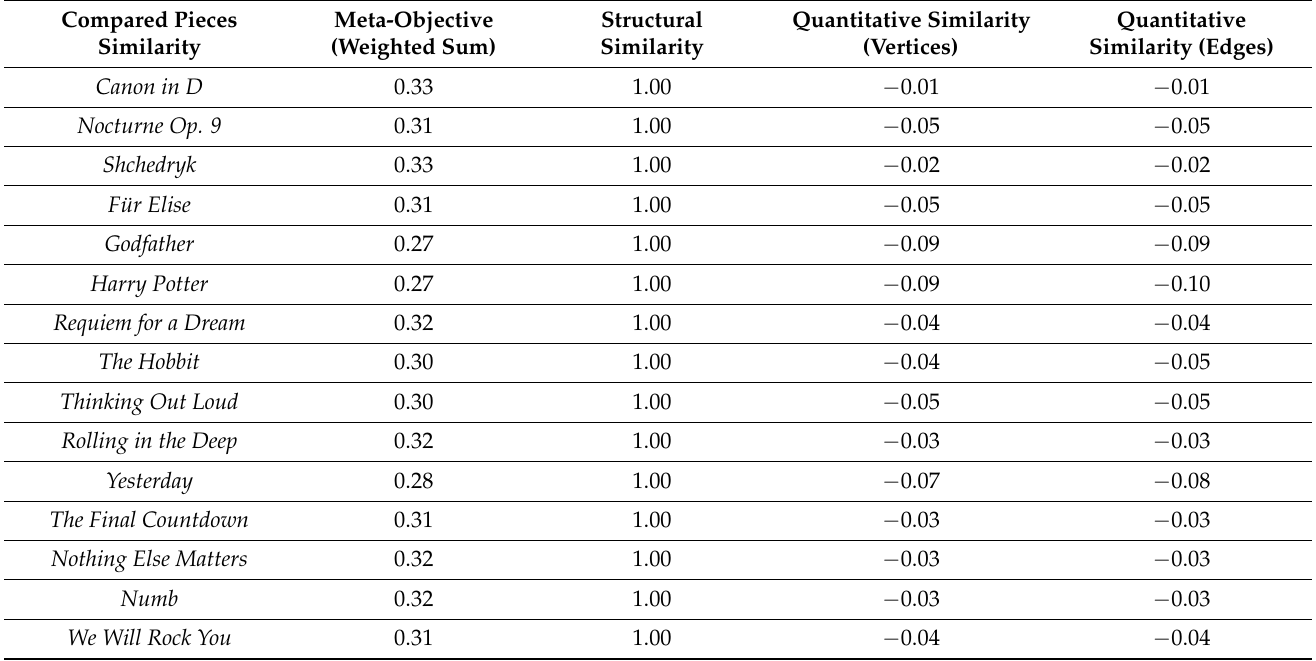
Table 7. Comparison of tracks and their